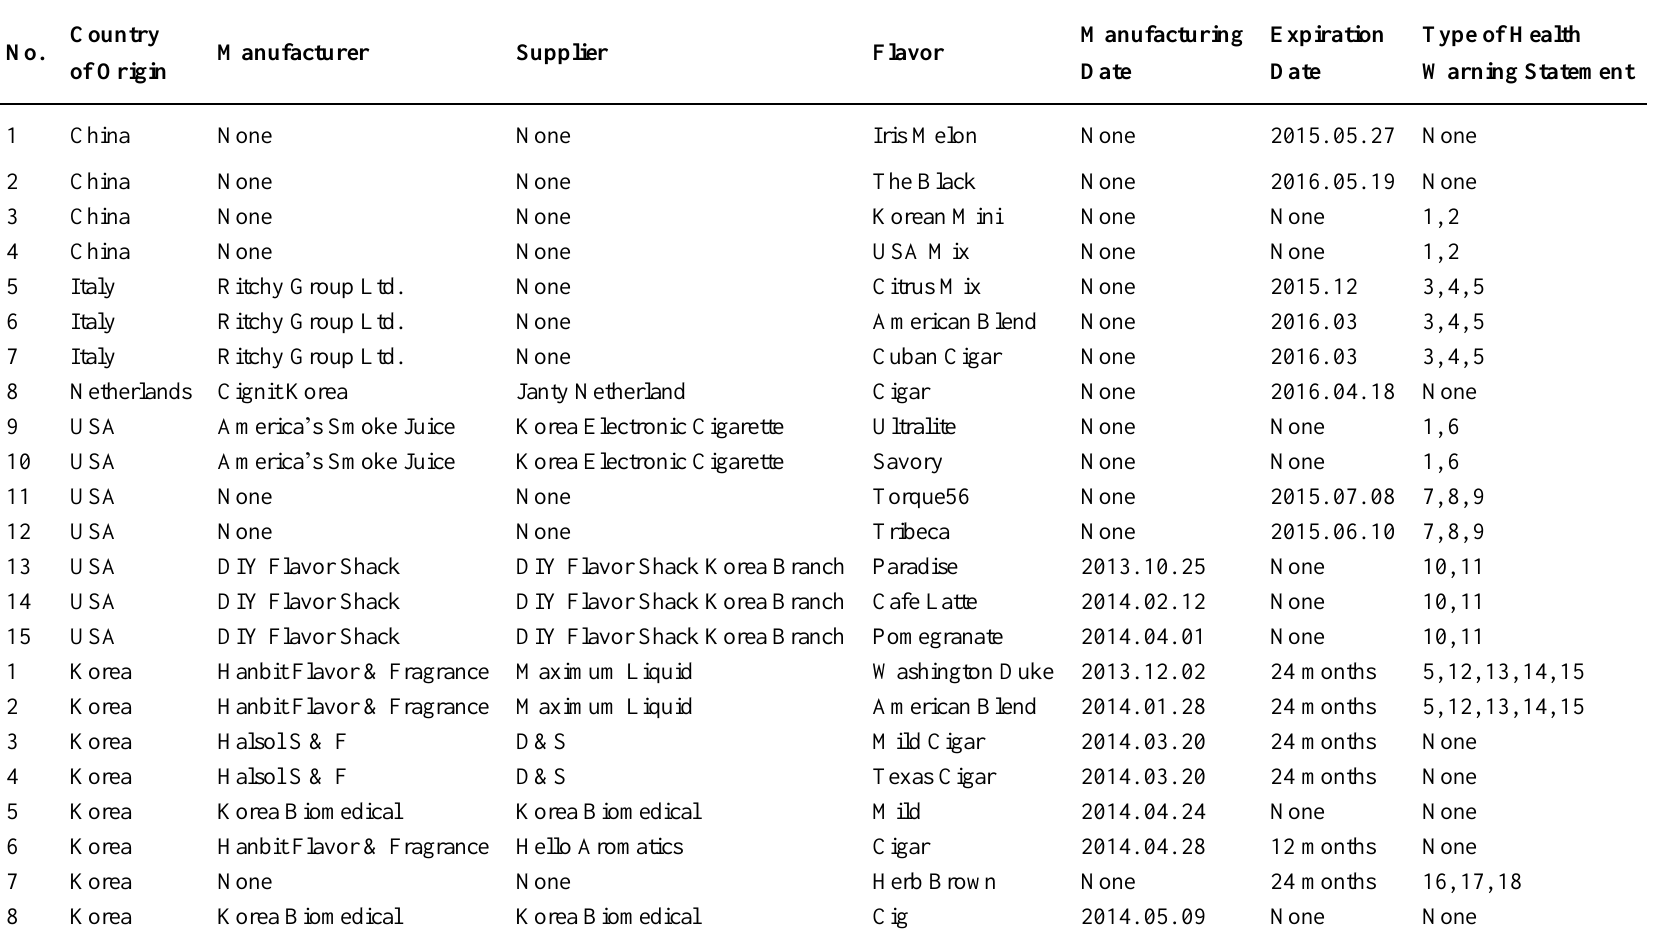
Table 1. Description of the liquid e-cig products, including countries of origin, manufacturers, suppliers, flavors, manufacturing and expiration dates, and types of health warning